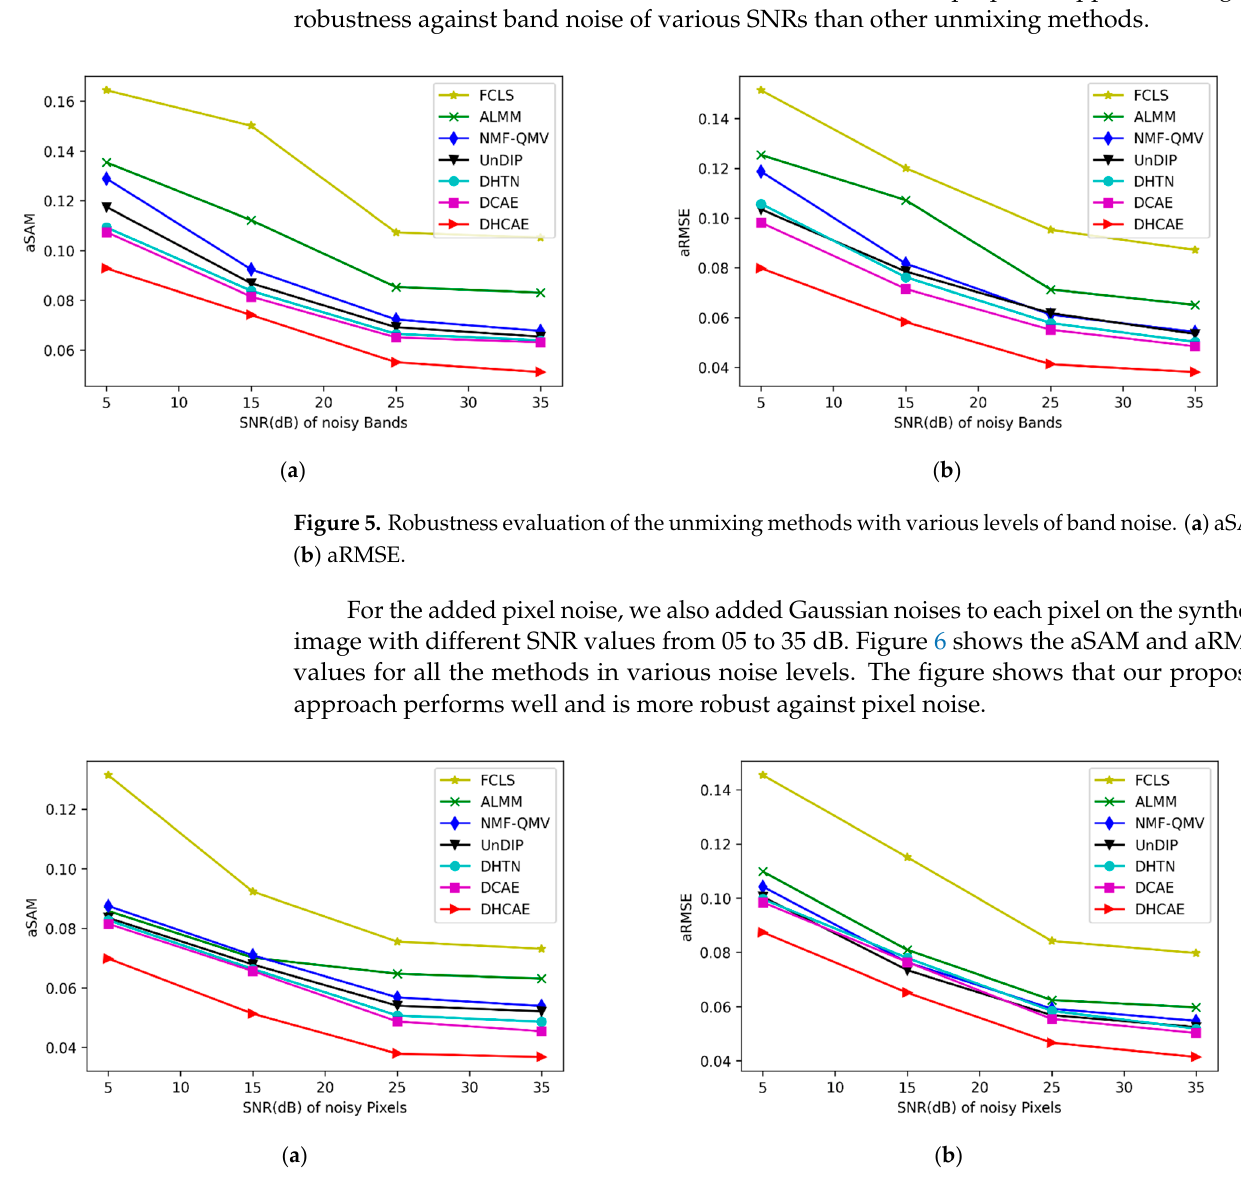
( b ) Figure 7. Robustness evaluation of the unmixing methods with various pixel and band noise levels. ( a ) aSAM. ( b ) aRMSE. 3.2. Experiments on Jasper Ridge Dataset The first real HSIs scene used in our experiments was the Jasper Ridge dataset cap- tured by the Airborne Visible/Infrared Imaging Spectrometer (AVIRIS), as shown in Fig- ure 8a. The image of size 100 × 100 pixels was measured in 224 spectral bands covering the wavelength range from 0.38 to 2.5 μ m. Tree, Water, Dirt, and Road are the four main endmembers observed in this dataset. In all 224 bands, there exist some noisy bands (2–4, 220–224) and blank bands (1, 108–112, 154–166). Figure 8b–e shows the noisy bands seri- ously corrupted by noise. The presence of noisy bands in the HSIs reduces the perfor- mance of the HSU methods. Therefore, to test the robustness of our proposed approach, we conducted experiments on data without noisy bands (i.e., bands = 198) and with noisy bands (i.e., bands = 224).